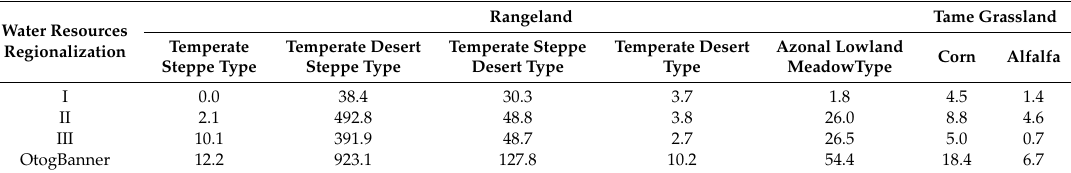
Table 2. Statistics on grazing grassland in OtogBanner (10 3 hm 2